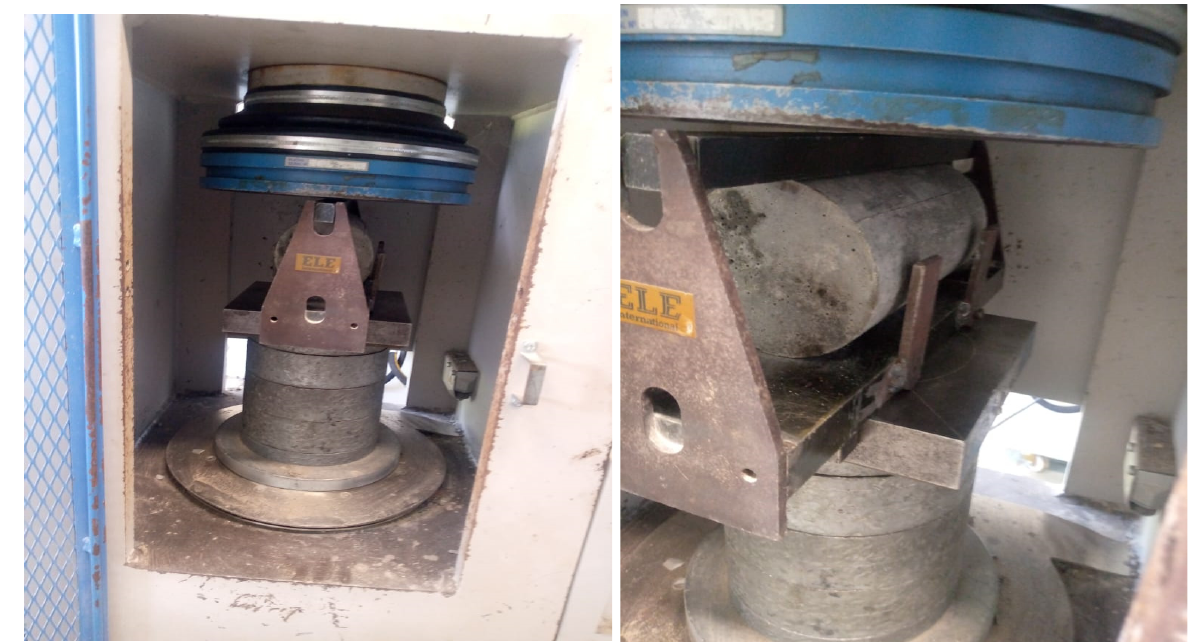
Figure 6. Split tensile strength laboratory testing.